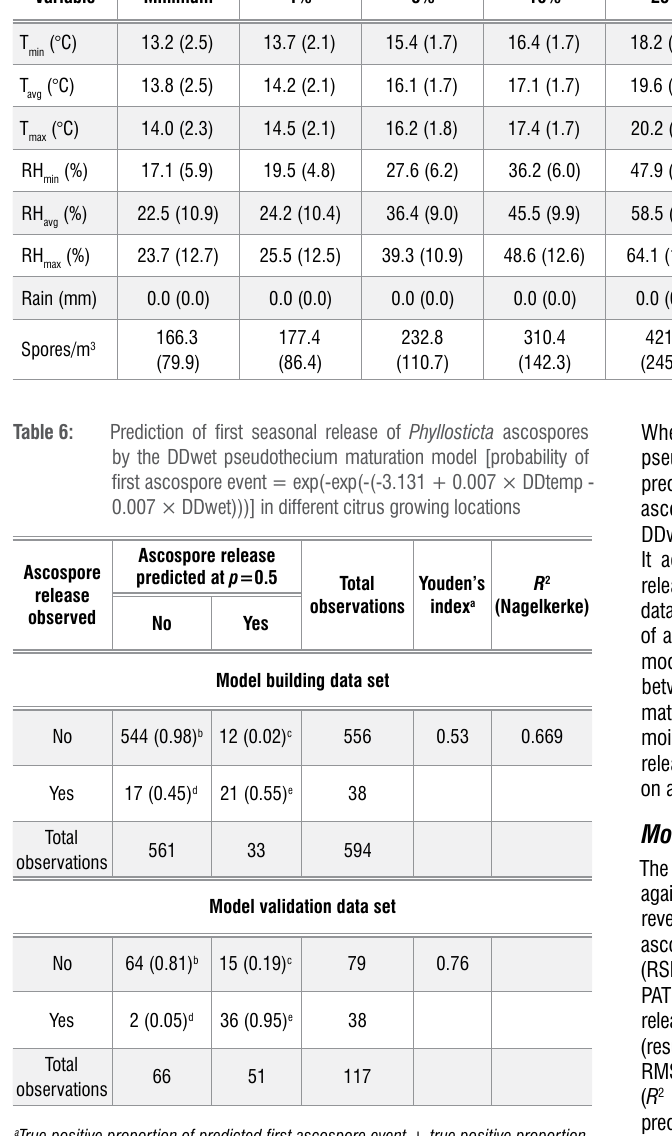
Means and coefficients of variation (%) of quantiles estimated for daily temperature (T), relative humidity (RH), rainfall and ascospore numbers measured on the 1798 days during which Phyllosticta ascospore release events were recorded at 13 localities over one to five seasons Variable